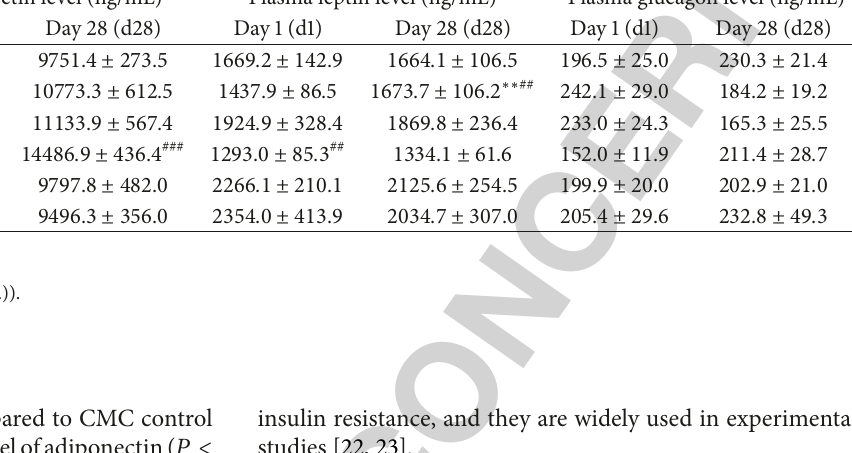
Table 3: Basal (non-fed sate) plasma adiponectin (ng/mL; M ± SEM), leptin (ng/mL; M ± SEM), and glucagon (ng/mL; M ± SEM) in Goto Kakizaki/Par male rats ( 𝑛 = 12 in each group).